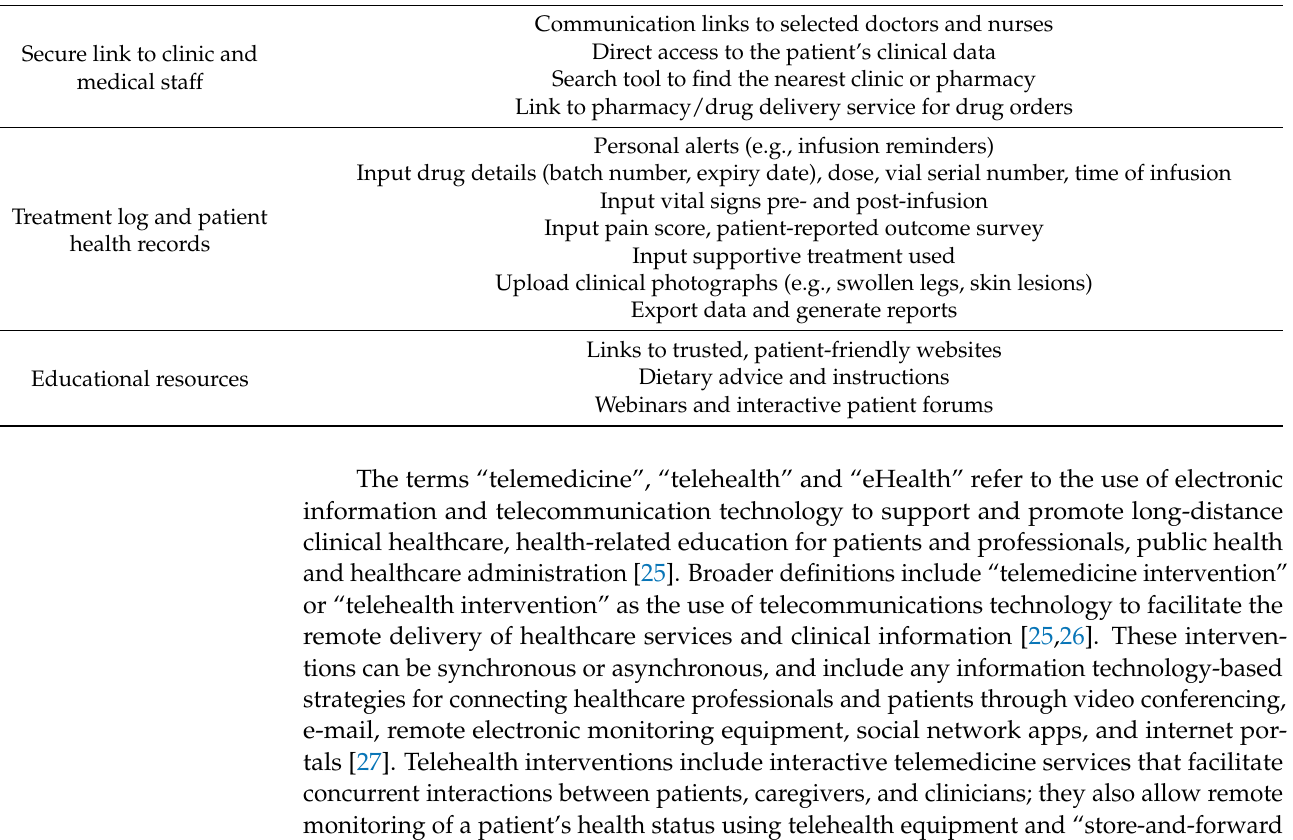
Table 2. Required functions of the mobile application to improve self-monitoring in patients with Fabry disease. Key Feature of Mobile